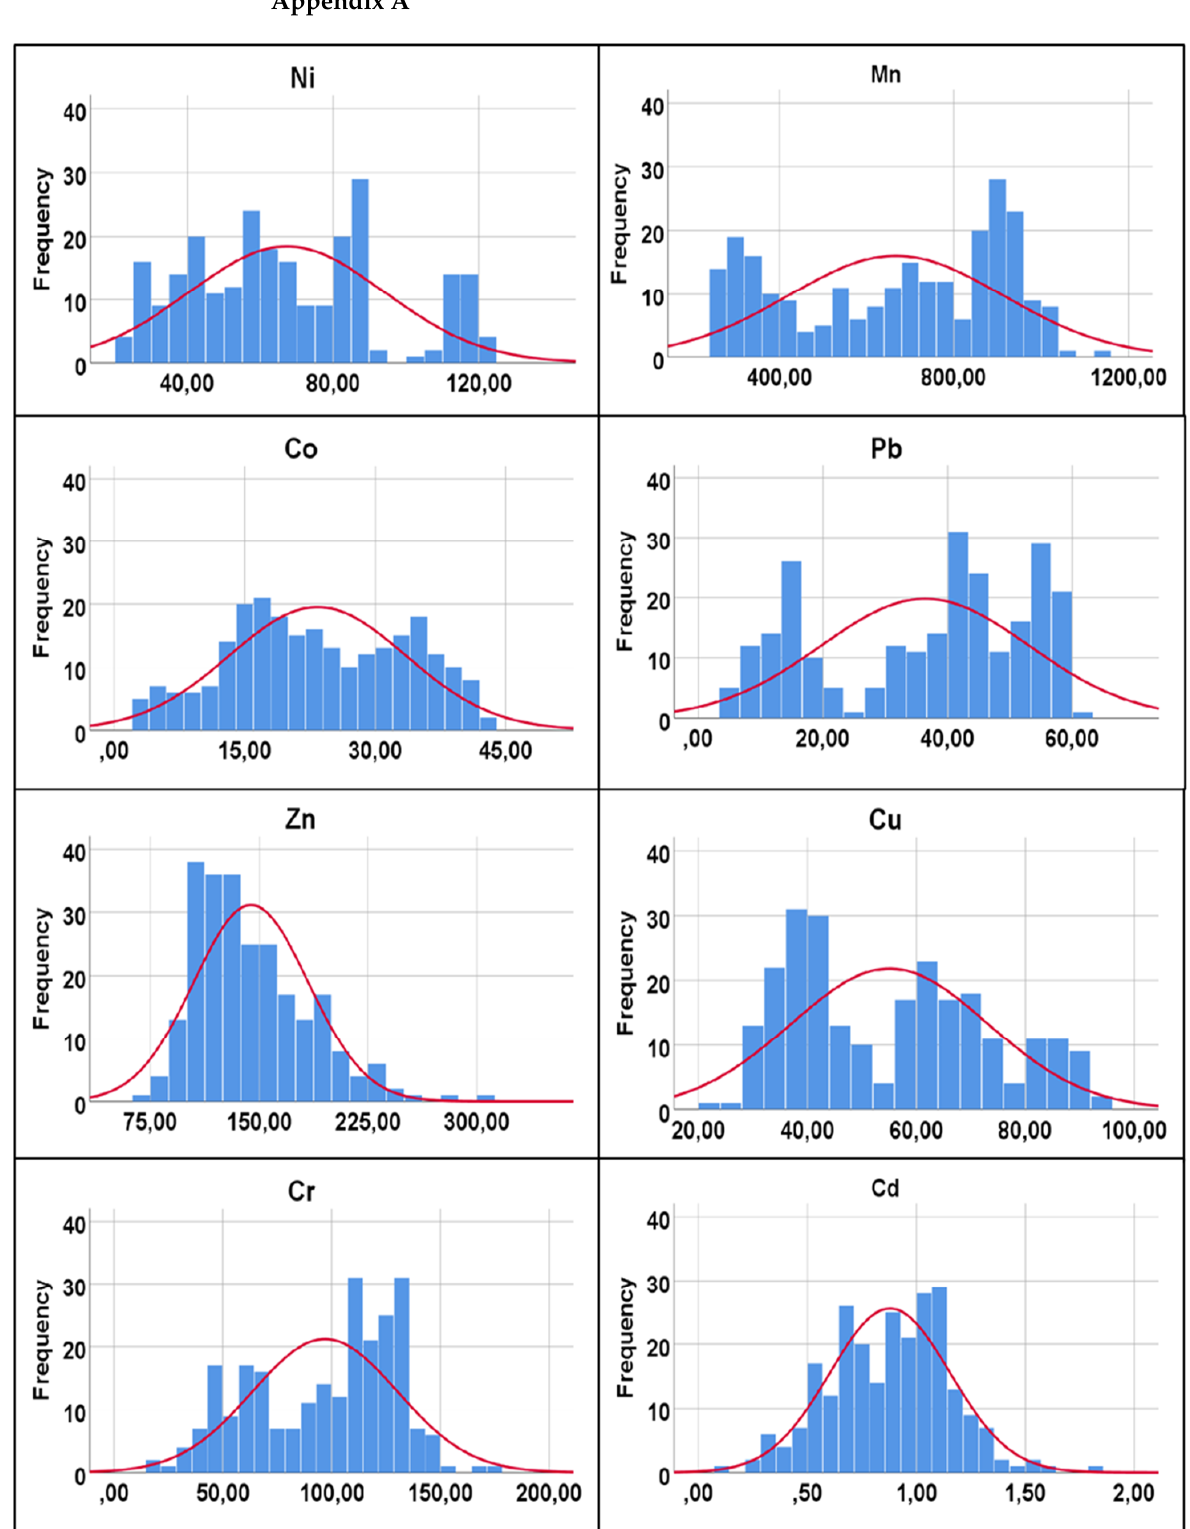
Figure A1. The bar charts of the eight HMs and the red lines which indicate the line of normal dis- tribution.